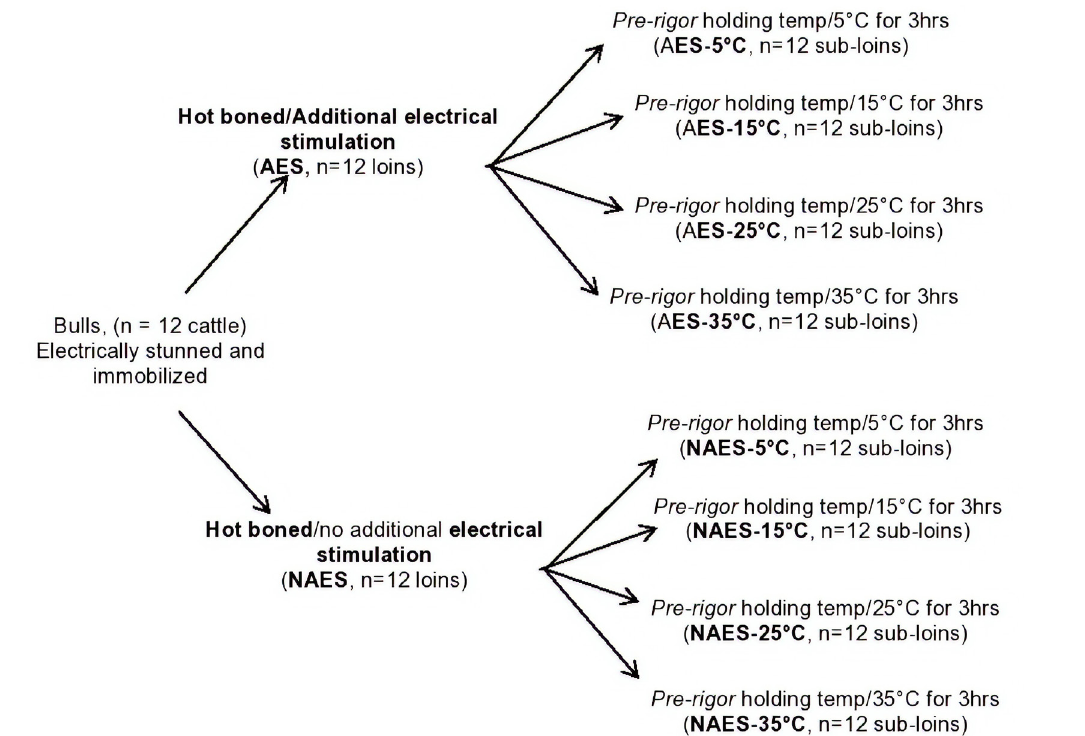
Figure 1. Experimental design to determine the influence of additional electrical stimulation (AES) and various pre-rigor holding temperature for 3 h post mortem of beef M. longissimus lumborum samples.